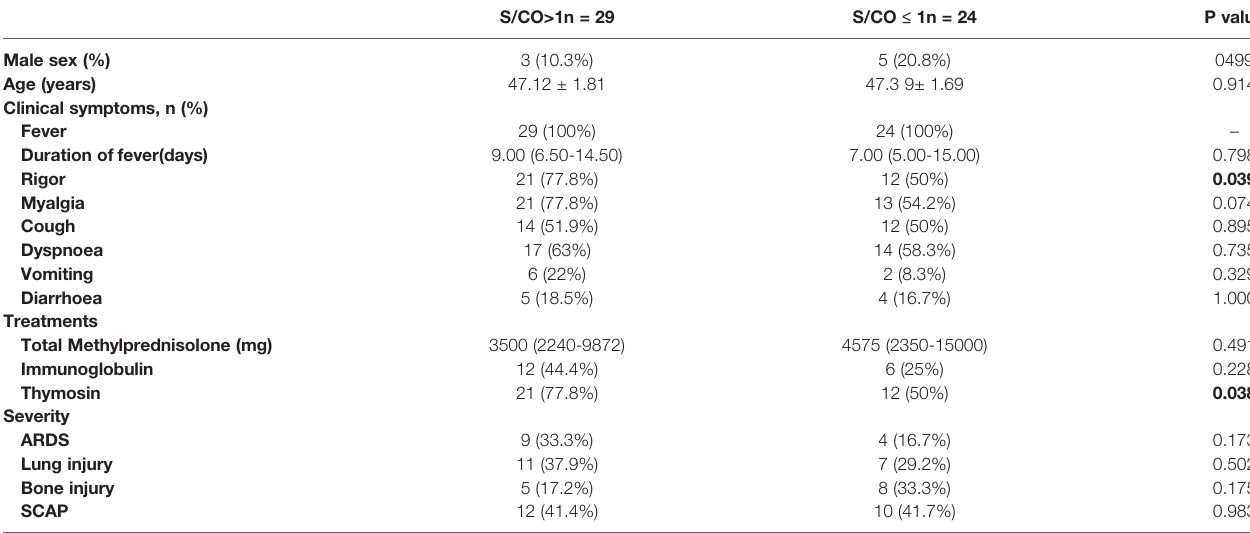
TABLE 2 | Clinical characteristics and treatments of SARS in